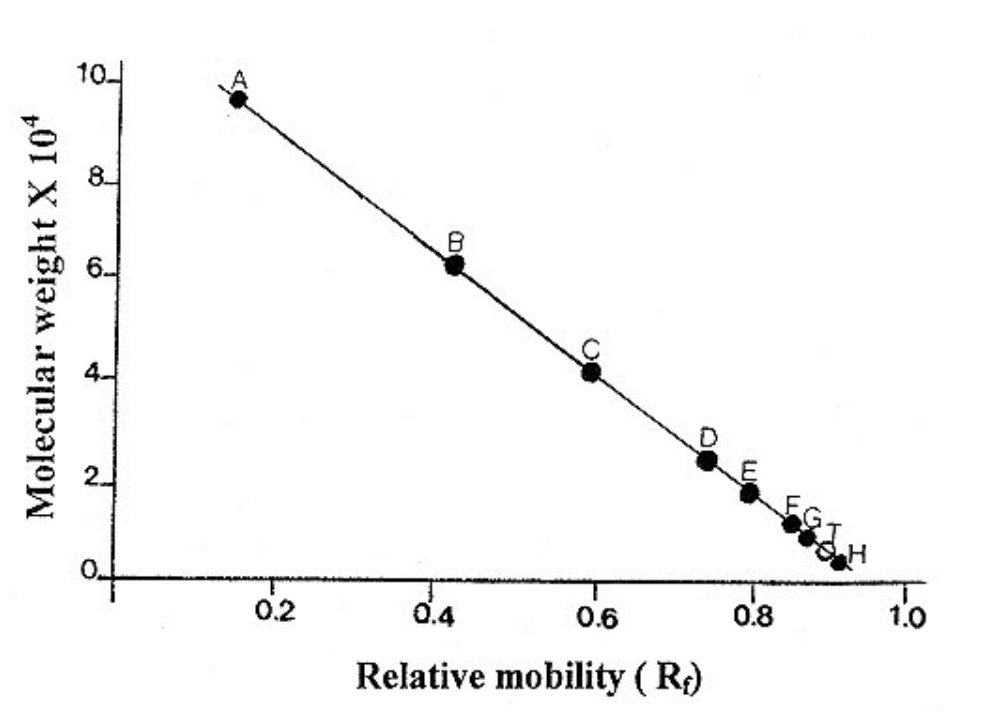
Figure 5: Calibration curve for the determination of the toxin molecular weight by SDS-PAGE (6-16%). Marker proteins used for calibration: A: Phosphorylase b (97,400); B: bovine serum albumin (66,000); C: ovalbumin (43,000); D: carbonic anhydrase (29,000); E: soyabean trypsin inhibitor (20,100); F: lysozyme (14,300); G: aprotinin (6,500); H: insulin; T: